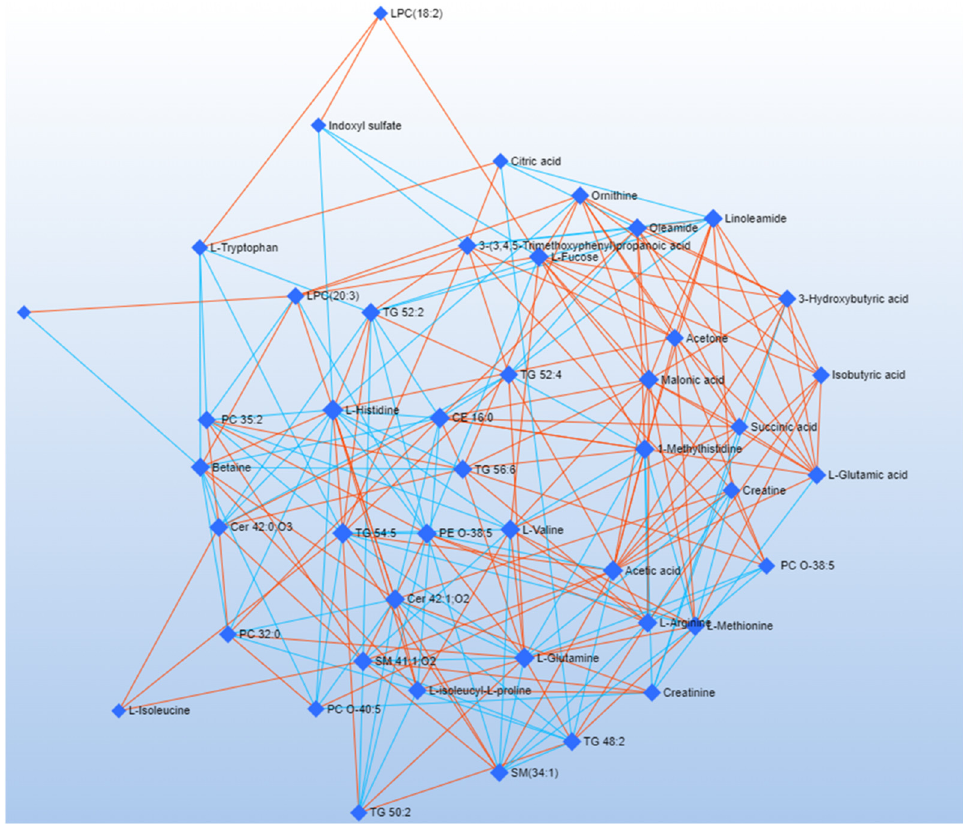
Figure 4. Correlation network obtained by DSPC algorithm using metabolites (VIP > 1) discriminating early ALS patients. Nodes represent metabolites. Red lines indicate a direct correlation between metabolites, blue lines indicate an inverse correlation.